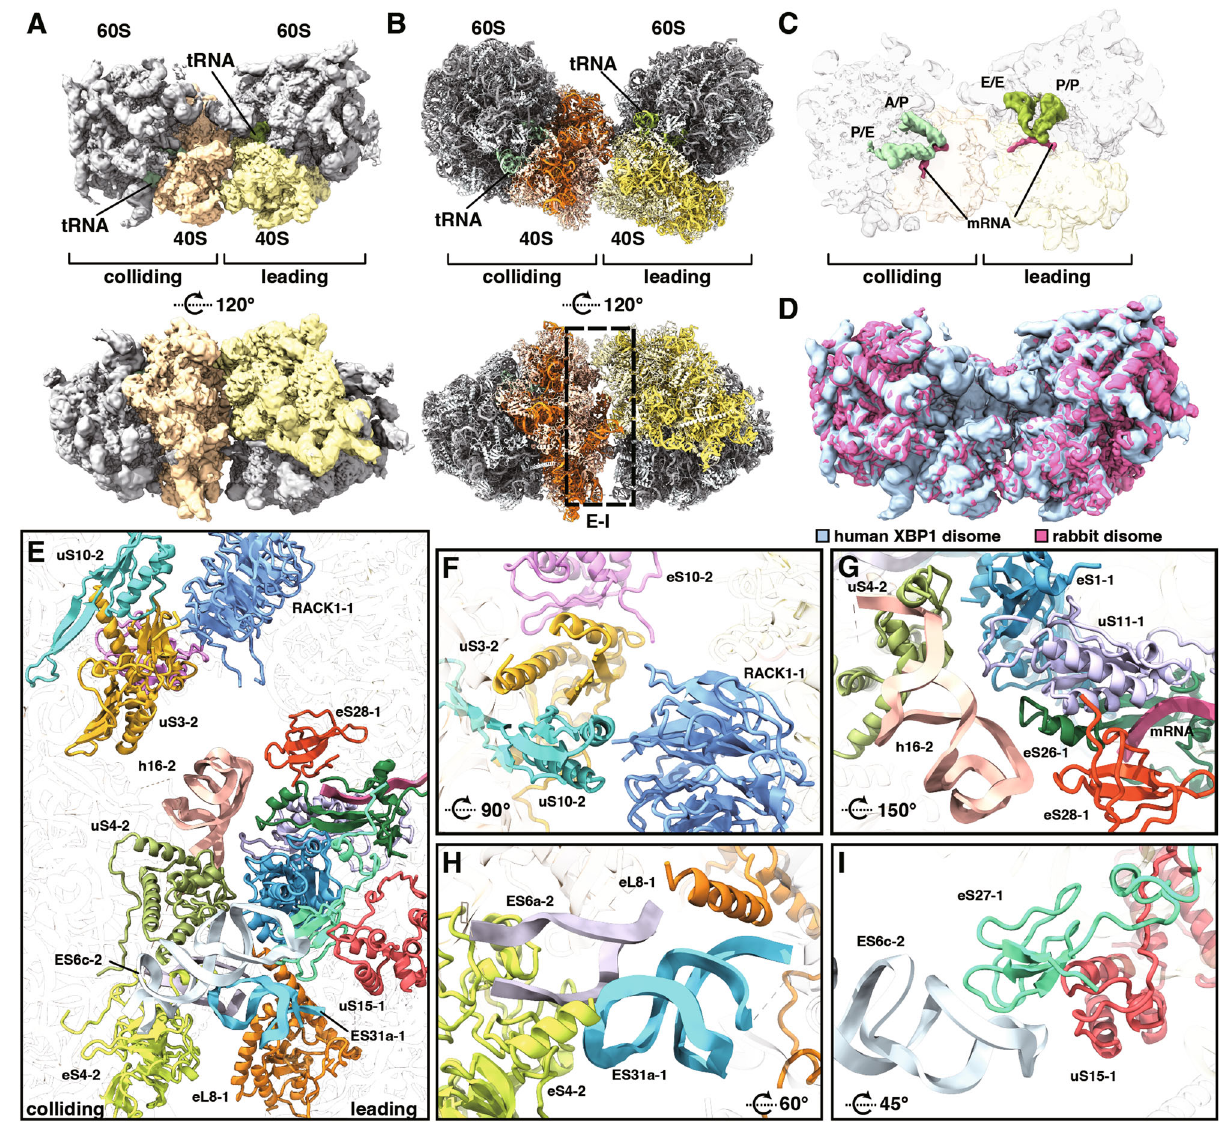
Fig. 2 | Cryo-EM structure comparison of the human XBP1-stalled disome and the yeast disome. A Composite cryo-EM density and the molecular model ( B ) of the human XBP1-stalled collided disome. C Cut-in view of the tRNA states. The leading ribosome is in a non-rotated POST-state with P/P E/E-tRNAs and an empty A-site. The colliding ribosome is in a rotated PRE-translocation state with A/P P/E hybrid tRNAs. D Cryo-EM structures of the human XBP1-stalled disome and the rabbiteRF1mutantstalleddisome(reconstructedfromindividualmapsEMD-0192, 0194, 0195, and 0197 10 ) were superimposed. Little variance in the inter-ribosomal orientation is observed between the two disomes. E Overview of the inter-